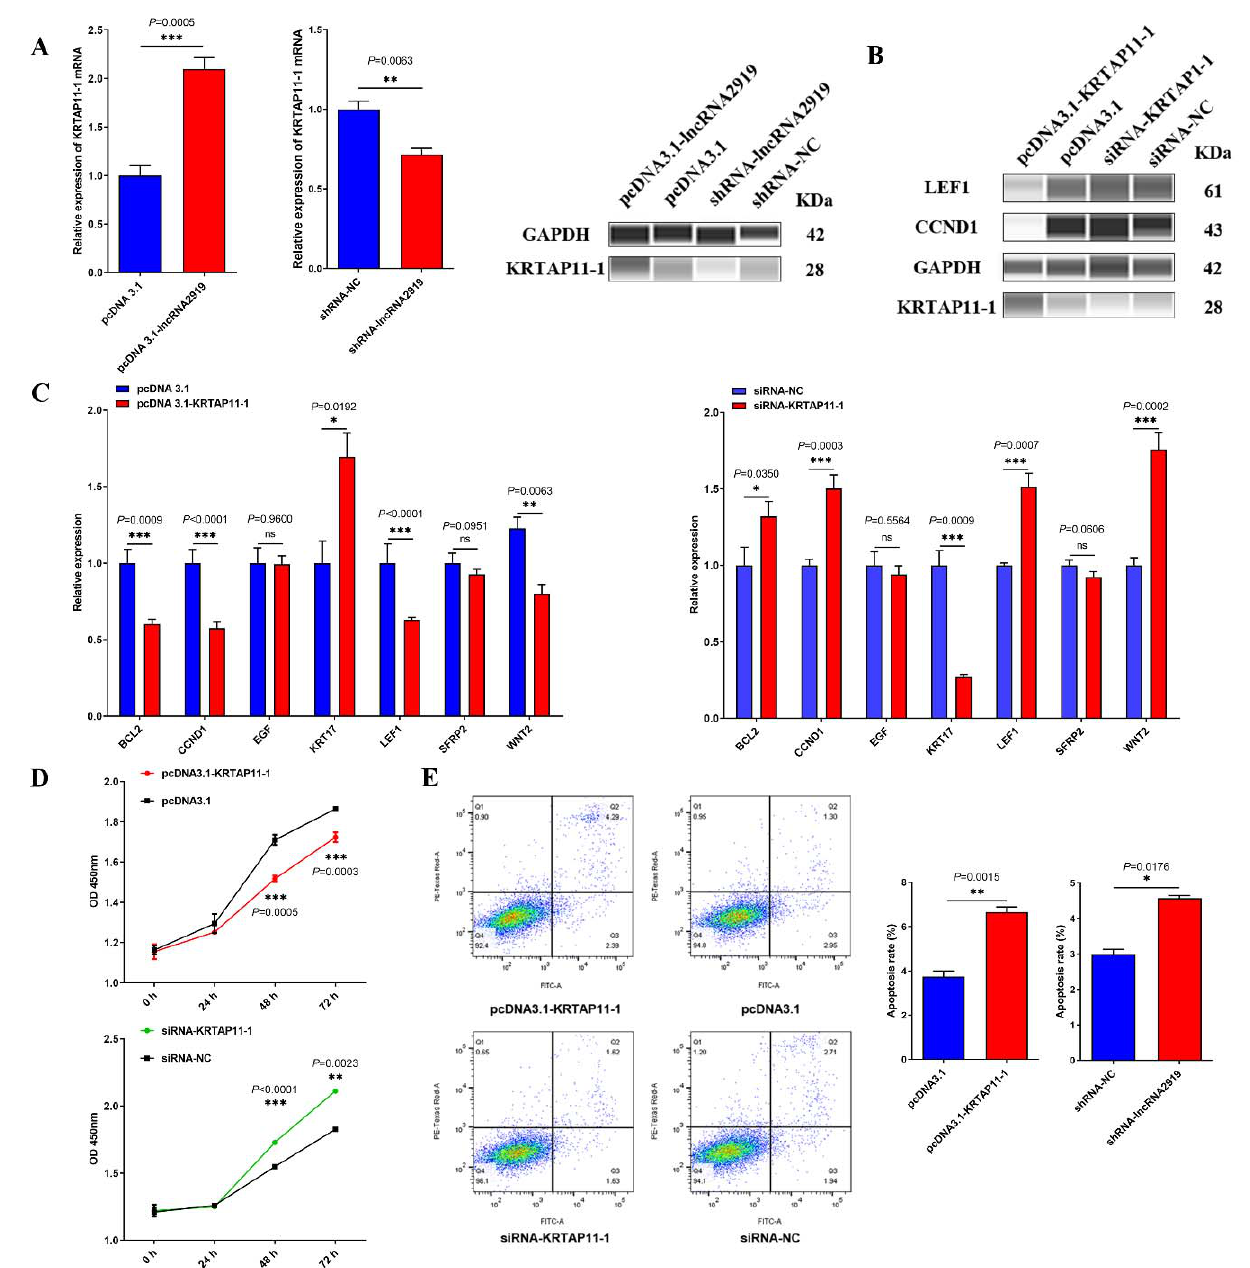
Figure 4. lncRNA2919 regulated the KRTAP11-1 expression. ( A ) lncRNA2919 overexpression and knockdown regulated the KRTAP11-1 mRNA and protein expression levels. ( B ) KRTAP11-1 regulated the expression of HF cycling and growth-related proteins. ( C ) KRTAP11-1 regulated the mRNA expression of HF cycling and growth-related genes after KRTAP11-1 overexpression and knockdown in DPCs. ( D ) Cell proliferations were estimated on the basis of KRTAP11-1 overexpression and knockdown in DPCs. ( E ) Cell apoptosis rates were determined on the basis of KRTAP11-1 overexpression and knockdown in DPCs. Data are presented as mean ± SEM, ns indicates not significant. A two-tailed paired t -test was used for the data analyses.